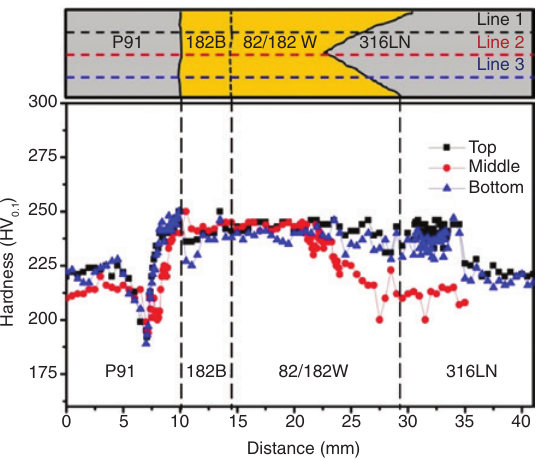
Figure 6: Microhardness variations across DMWJ.